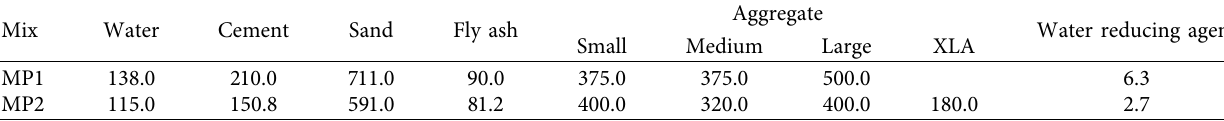
Table 1: Te mix proportion of hydraulic concrete kg · m − 3